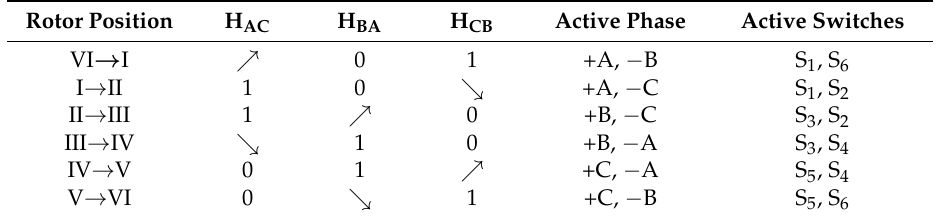
Figure 3. Line BEMF and the digital position signal. H AC , H BA and H CB : digital position signals. Table 1. Commutation control strategy for BLDCM.